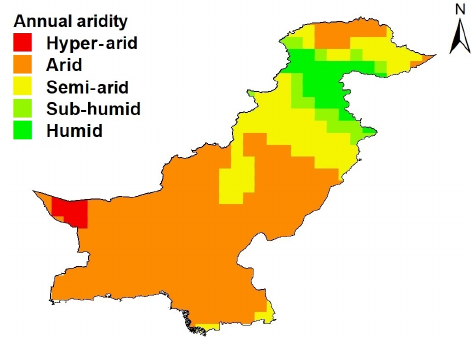
Figure 2. Aridity classification of Pakistan (adopted from Ahmed et al.,